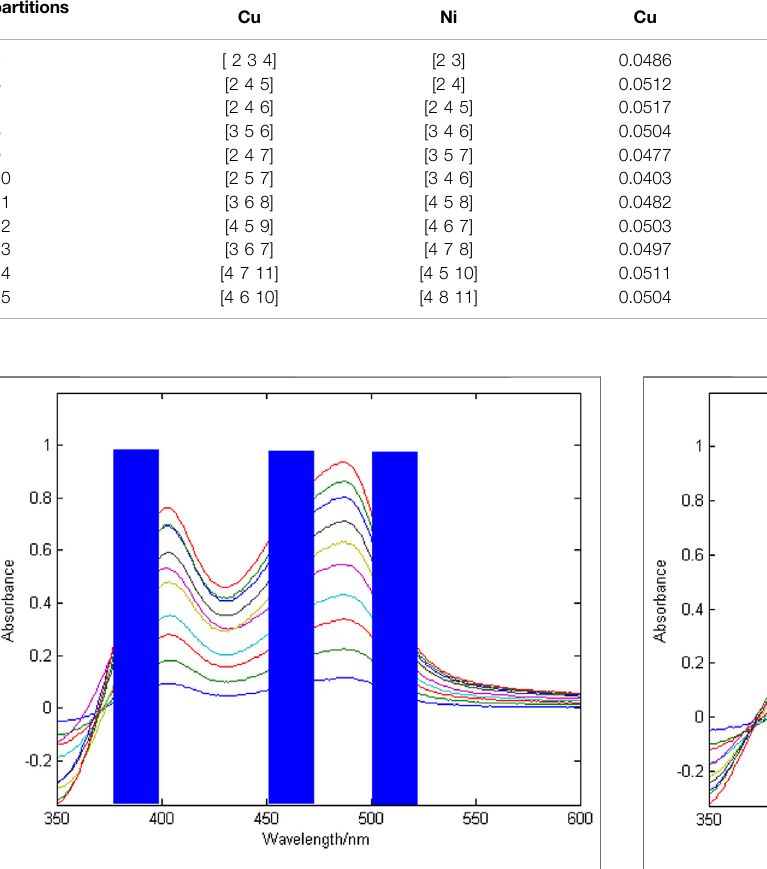
FIGURE 6 | Combined wavelength screening results for nickel characteristic